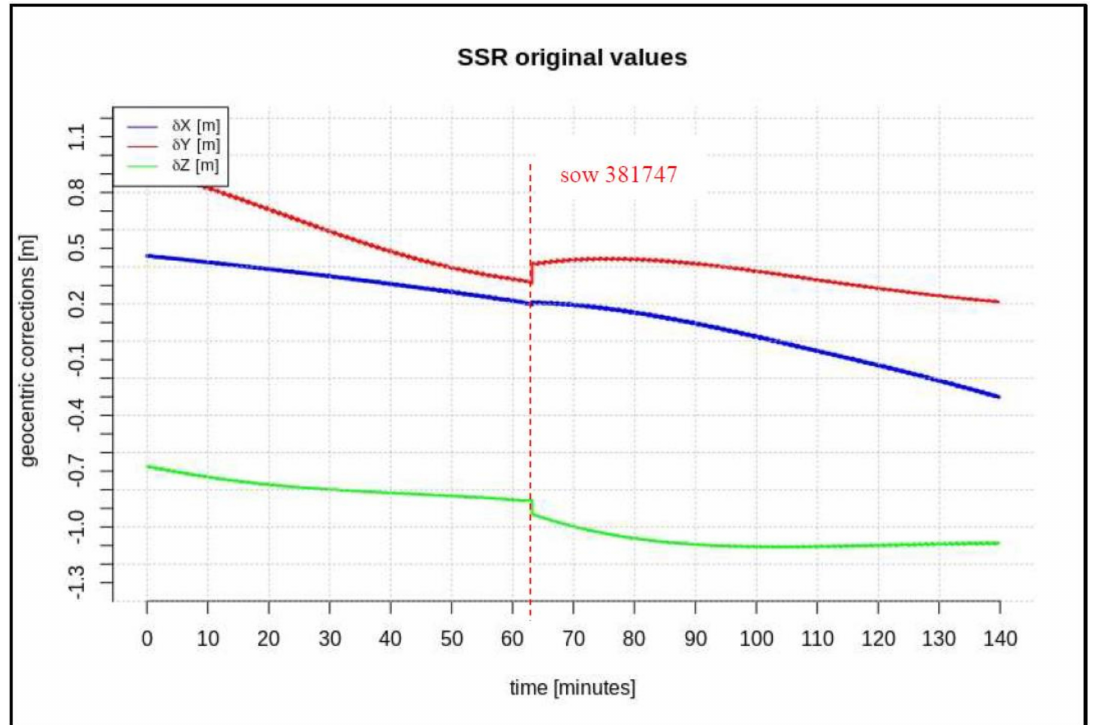
Figure 2. Time series of the geocentric corrections δ P of DOY 99, GPS 13.